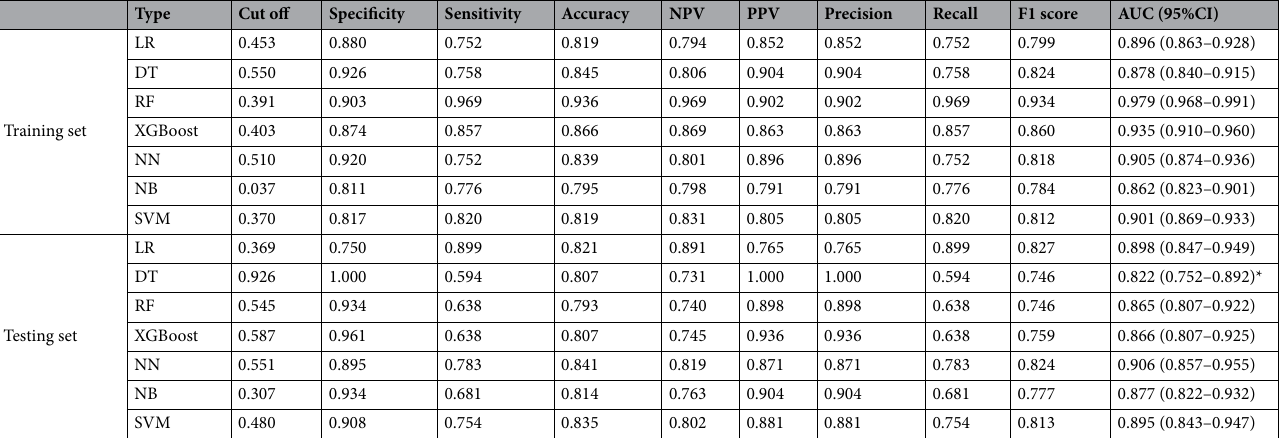
Table 2. The performance of machine learning models. LR logistic regression, DT decision tree, RF random forest, NN neural network, NB naïve bayes, SVM support vector machines, NPV negative predictive value, PPV positive predictive value. *The AUC of DT model was significantly different from that of LR algorithm (Delong test), while others